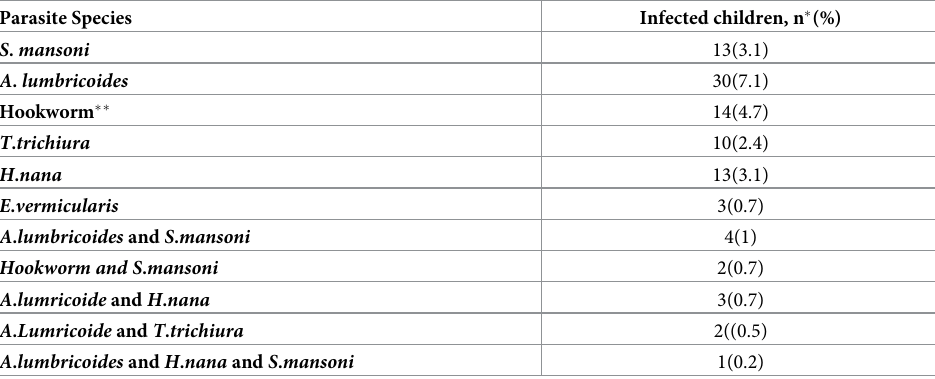
of intestinal helminths infections than the urban ones (Table 3). EPG of stool specimen examined. Among the infected children, 55% and 45% had light and moderate intensity of S . mansoni infection, respectively, but none had heavy infection. Table 2. Distribution of intestinal helminth infections among the study participant schoolchildren in northwest Ethiopia, N = 421. Parasite